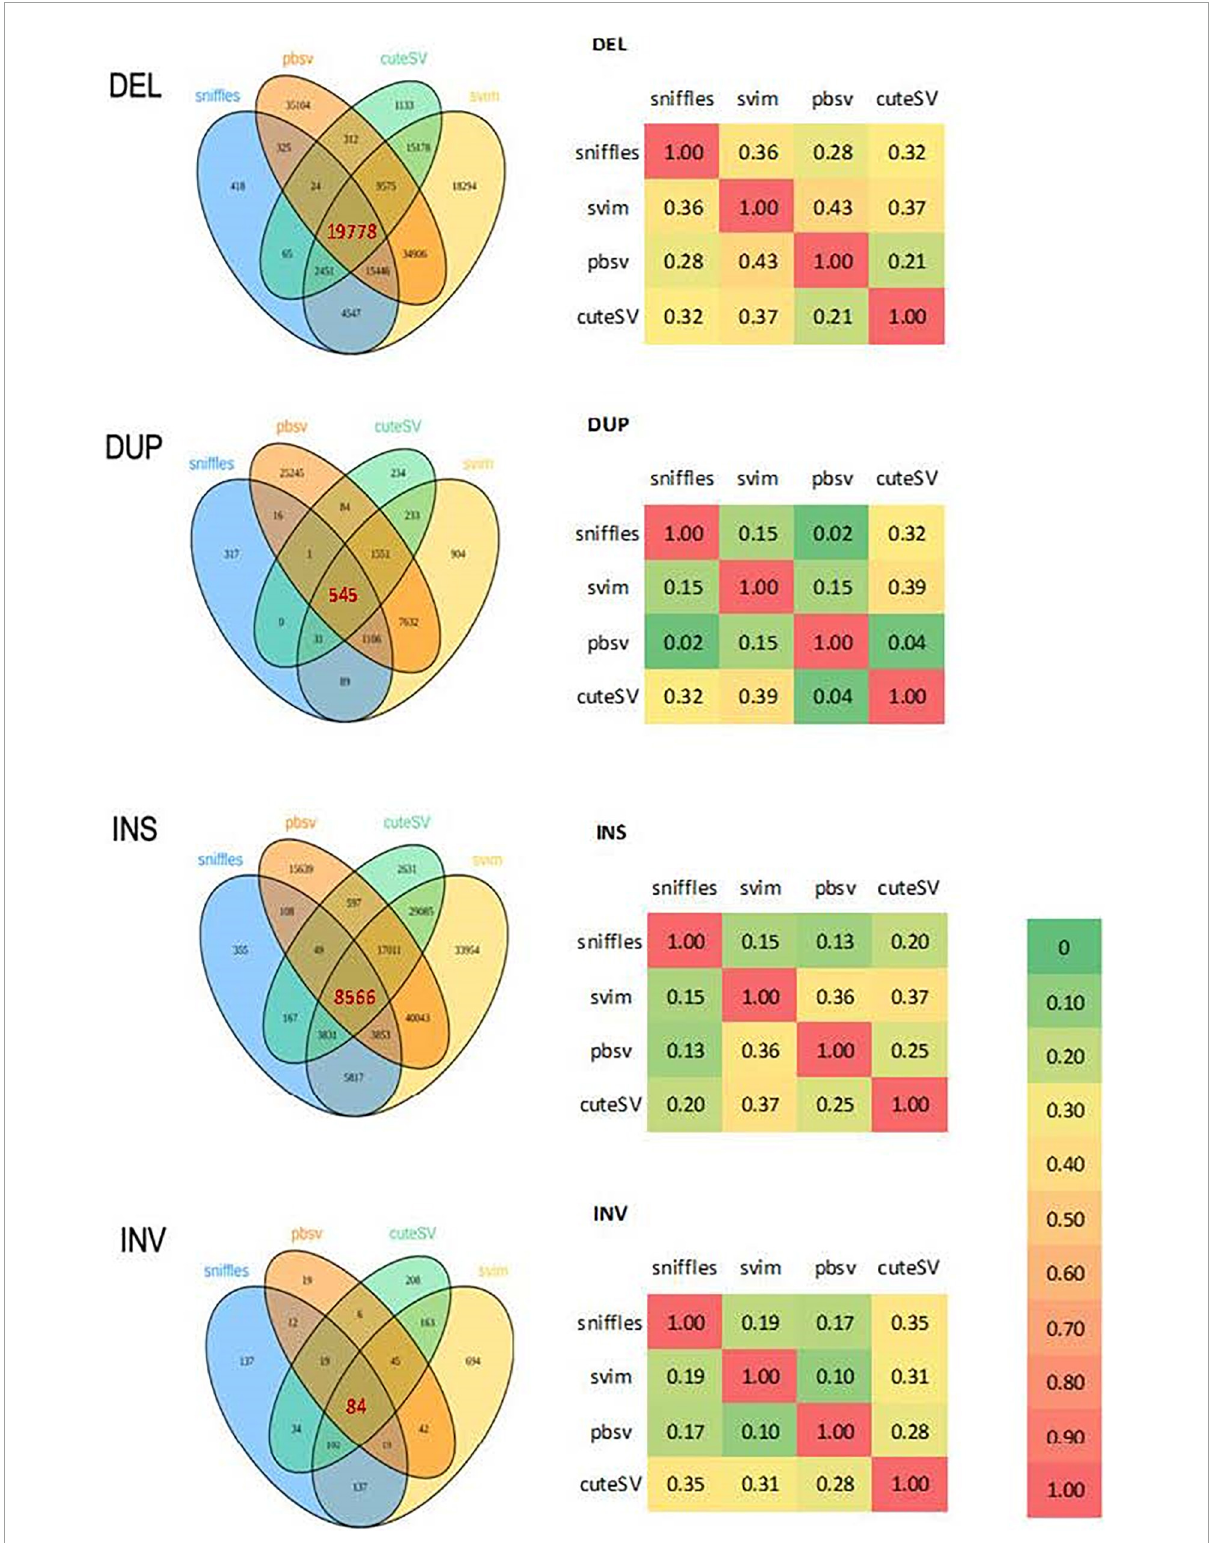
FIGURE2 Venn diagrams and correlation matrices of structural variations detected by 4 programs from PacBio in 10 probands. DEL, deletion; DUP, duplication; INS, insertion; INV, inversion.